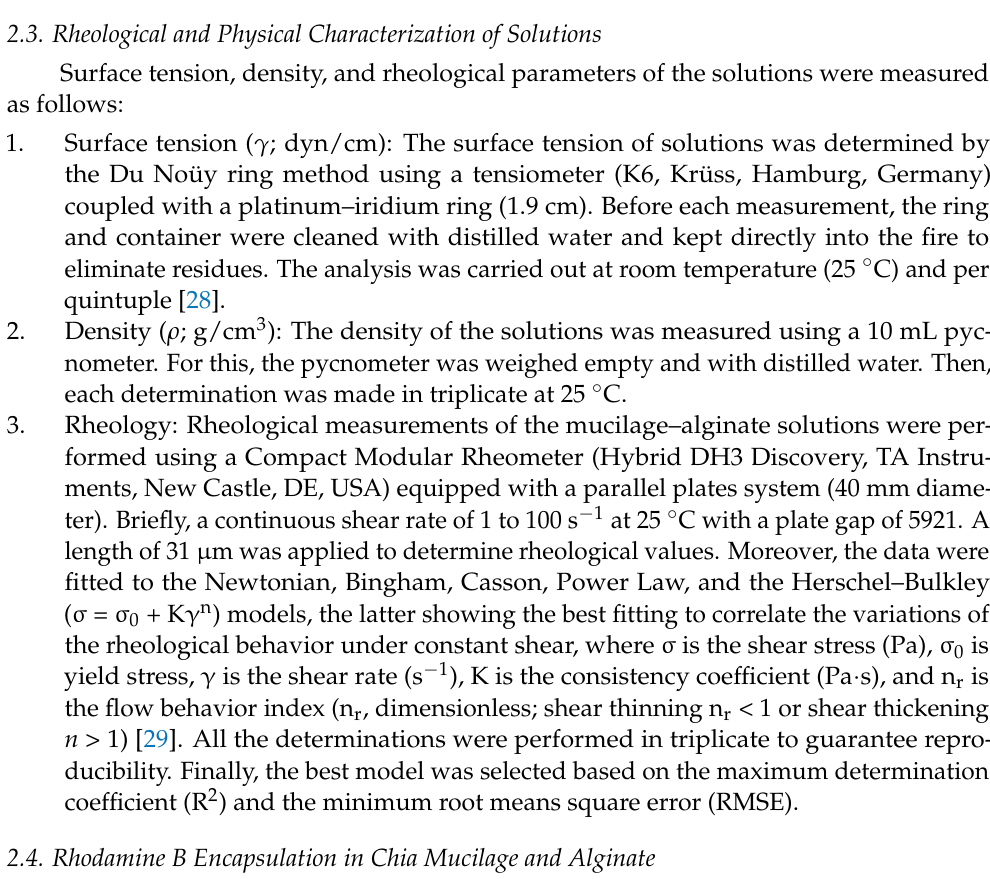
Table 1. Mucilage–alginate solutions at 1% w/v , used for the encapsulation process. Mucilage Concentration (MU% w)